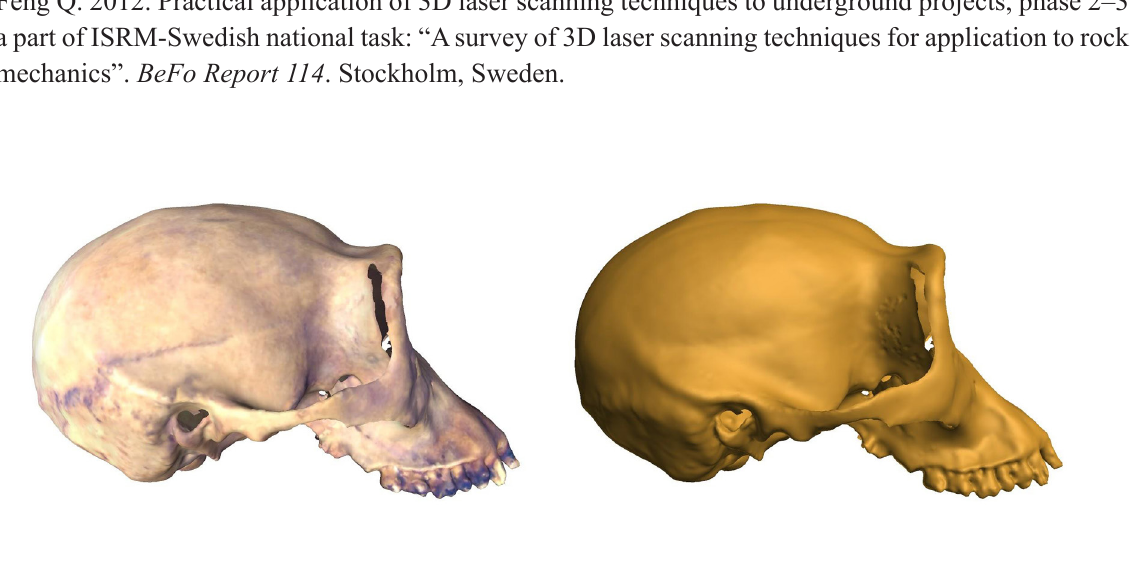
Fig. 3.31. Skull of Pan paniscus (RMCA) scanned with NextEngine. Left: the mesh with texture; right: the mesh without texture.